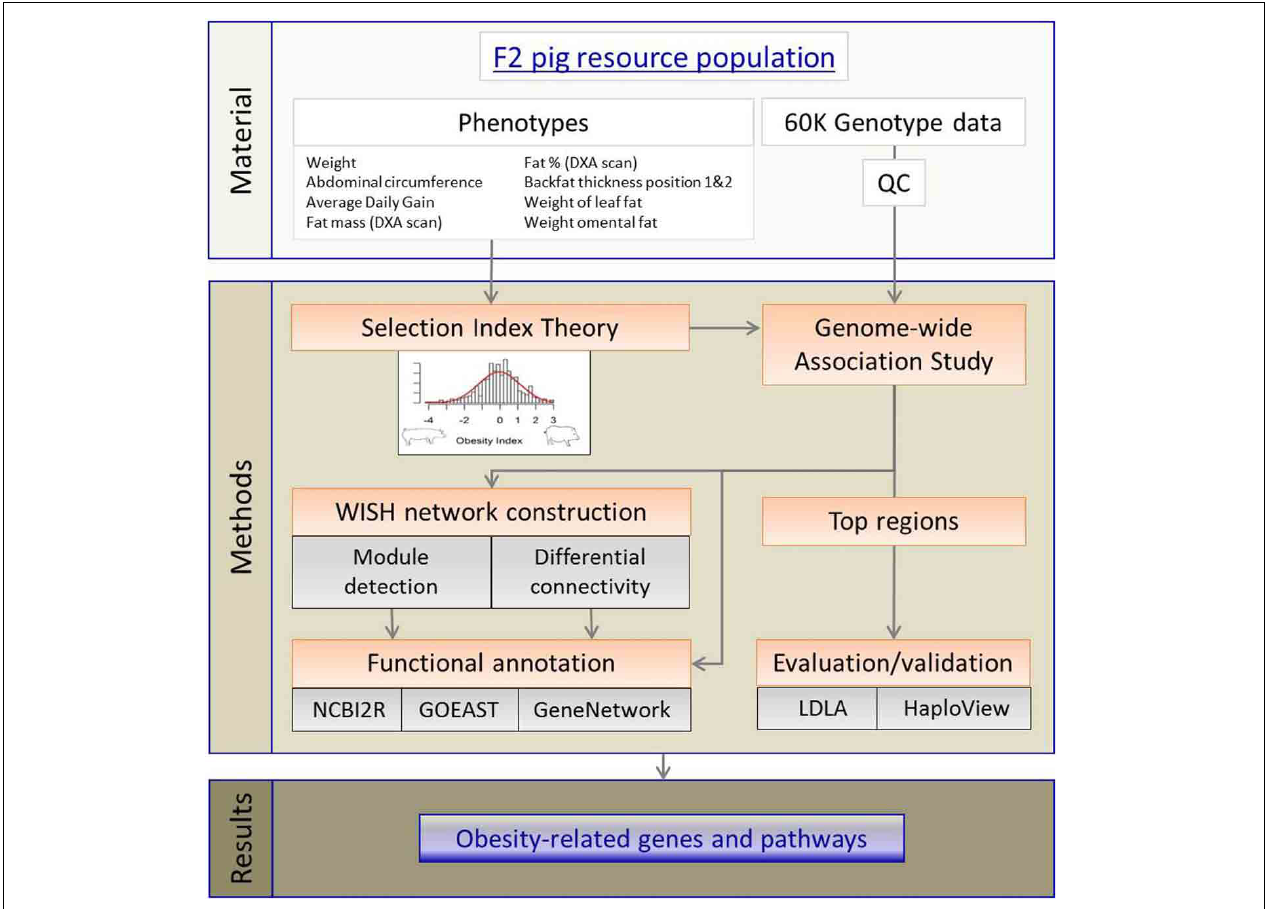
FIGURE 6 | Workflow visualizing the different methods to detect obesity-related genes and